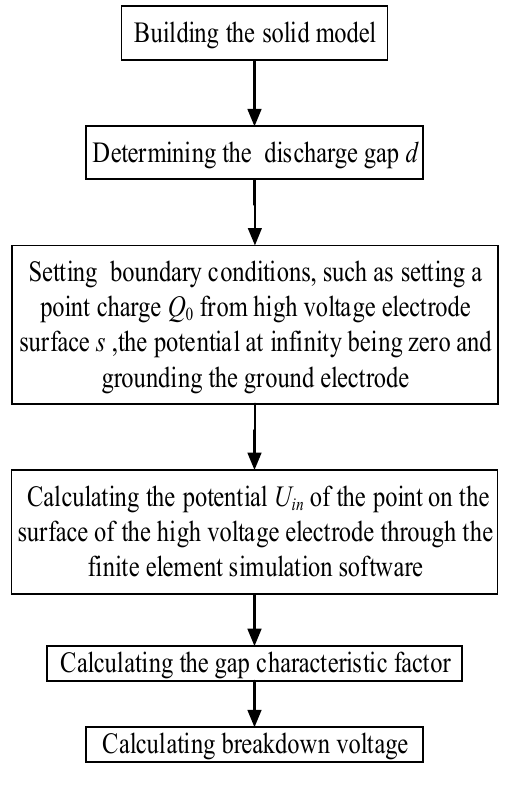
Figure 2. Flow chart of the finite element simulation method.